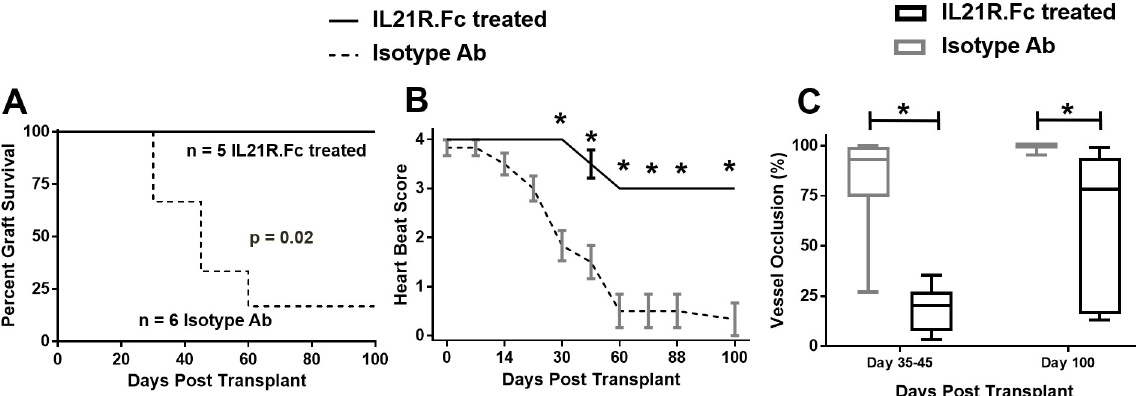
Fig 6. Heart transplant graft evaluation in IL21R.Fc treated WT mice in a chronic rejection model. Graft survival (A), heart beat scoring (B), and vessel occlusion (C) over time in Isotype Ab or IL21R.Fc treated WT recipients of heart transplants from bm12 mice. Significance approximated by Mantel-Cox test (A), 2-way ANOVA with Bonferroni post-tests (B), and unpaired Student’s t-test (C) � indicates p < 0.05. C) Grafts were recovered on the indicated day, cut, and stained for elastin. Percent occlusion was determined by tracing the internal elastic lamina and lumen of each vessel and calculated by % occlusion ¼ ½ Area of internal lamina �(cid:0) ½ Area of lumen � � 100 . The number of mice and vessels were as ½ Area of internal lamina �